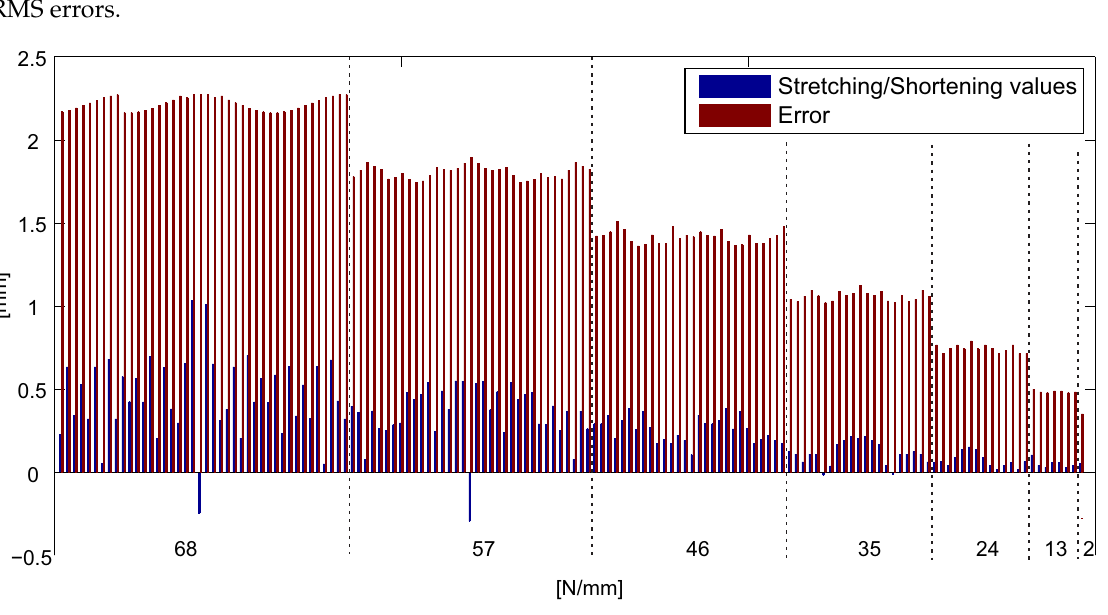
Figure 12. Error and correction values (flexible case).